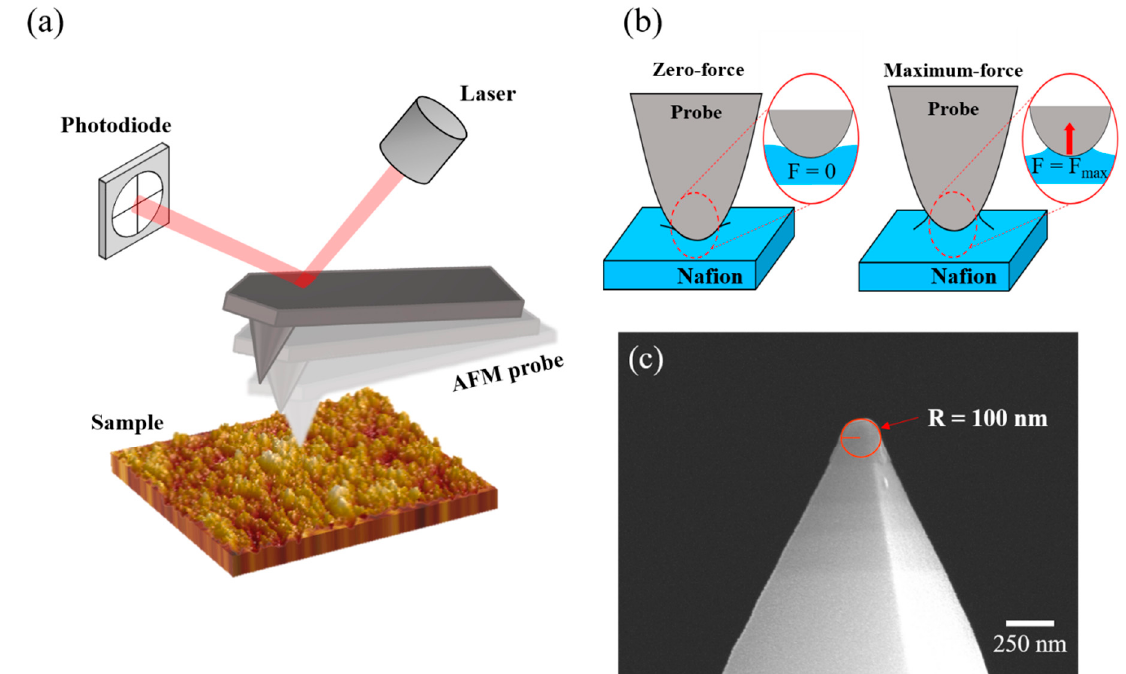
Figure 2. ( a ) A schematic of the measurement of Young’s modulus of pristine and thermally annealed Nafion ® membranes through Z spectroscopy mode of an AFM. ( b ) A schematic of the two-point method to obtain Young’s modulus, which is calculated by measuring deformations at zero-force ( F = 0) and maximum-force ( F = F max ) points [42]. ( c ) SEM image of the end of the AFM probe tip used.